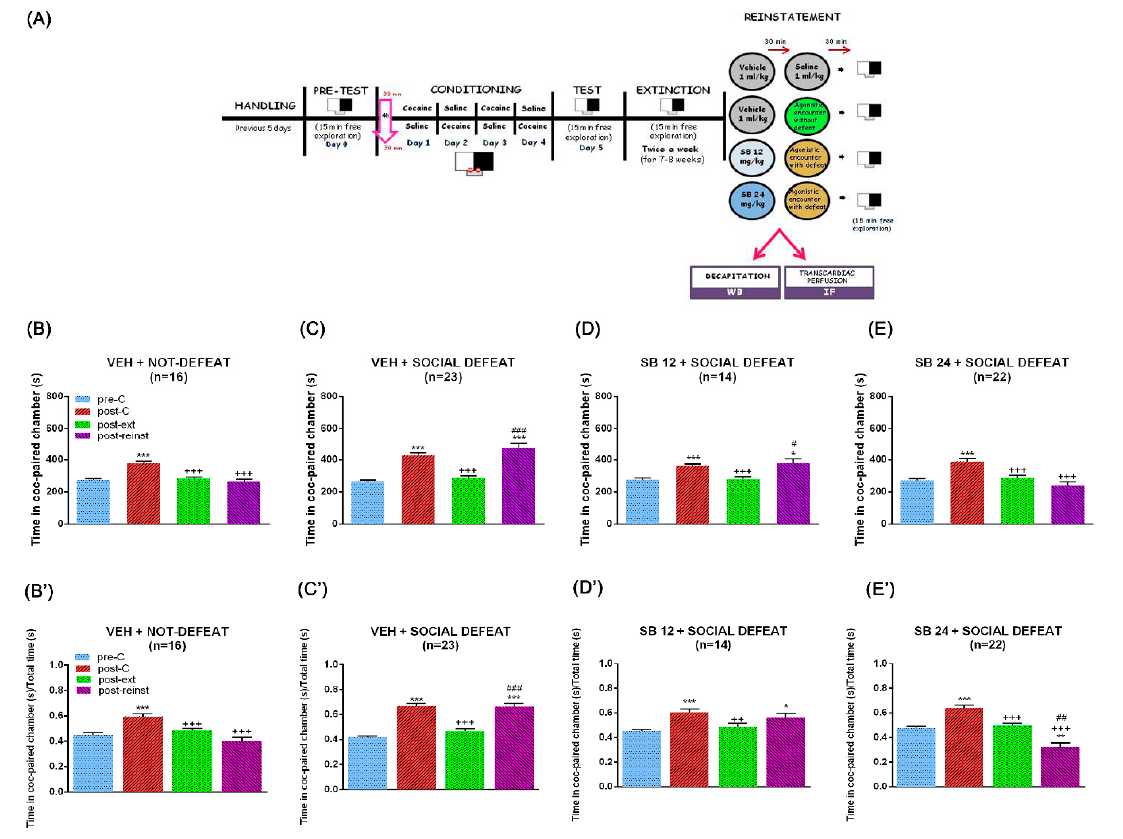
Figure 2. Timeline of the behavioural experimental procedure and effects of selective D3DR blockade with SB-277011-A (12 or 24 mg/kg i.p.) on the reinstatement of CPP induced by agonistic encounter with defeat. ( A ) Schematic representation showing. After 5 habituation and handling days, on day 0 animals were placed in the central corridor and allowed to explore the apparatus freely for 15 min. For each mouse, one chamber was randomly chosen to be paired with cocaine and the other chamber with saline. During days 1–4, animals were treated with cocaine and saline (conditioning sessions). The CPP test was conducted on day 5, exactly as in the preconditioning phase. Once achieved the criterion of extinction, a second session was performed 48 h later in order to confirm extinction. One day after the second extinction test, different groups of mice received vehicle or SB-277011-A (12 or 24 mg/kg i.p.) 30 min before agonistic encounter with or without defeat. Fifteen min after the agonistic encounter, mice were allowed to explore the apparatus freely (reinstatement test) and were sacrificed 15 min later, immediately after the reinstatement. ( B – E ) show the mean preference time spent in the cocaine-paired chamber during the pre-conditioning (pre-C), post-conditioning (post-C), post-extinction (post-ext), and reinstatement (post-reinst) in male mice pretreated with vehicle plus agonistic encounter without defeat ( B ), vehicle plus agonistic encounter with social defeat ( C ), and SB-277011-A (12 or 24 mg/kg i.p.) plus agonistic encounter with social defeat (( D , E ), respectively). ( B’ – E’ ) show the mean ratio of preference between the time spent in the cocaine-paired chamber and the total time spent in both chambers during the pre-C, post-C, post-ext, and reinst tests in male mice pretreated with vehicle plus agonistic encounter without defeat ( B’ ), vehicle plus agonistic encounter with social defeat ( C’ ), and SB-277011-A (12 or 24 mg/kg i.p.) plus agonistic encounter with social defeat (( D’ , E’ ), respectively). * p < 0.05, ** p < 0.01, *** p < 0.001 vs. pre-C; ++ p < 0.01, +++ p < 0.001 vs. post-C; # p < 0.05, ## p < 0.01, ### p < 0.001 vs. post-ext. Each bar corresponds to mean ± standard error of the mean (n = 14–23 per